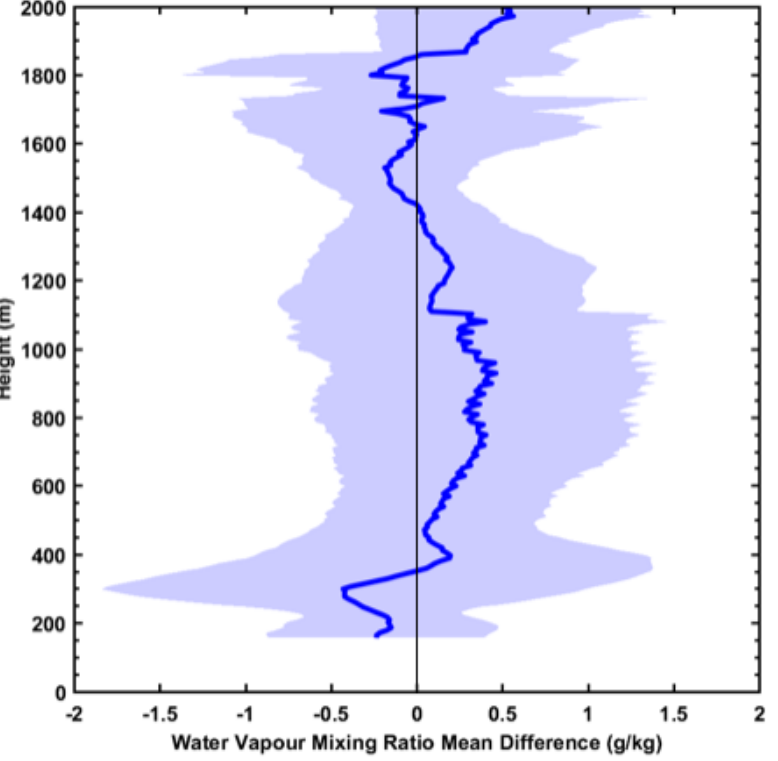
Figure 6. Total average difference (DIAL–Raman) for all 20-min average profiles from all eight nights during the inter-comparison campaign. The standard deviation is also shown (shaded region).